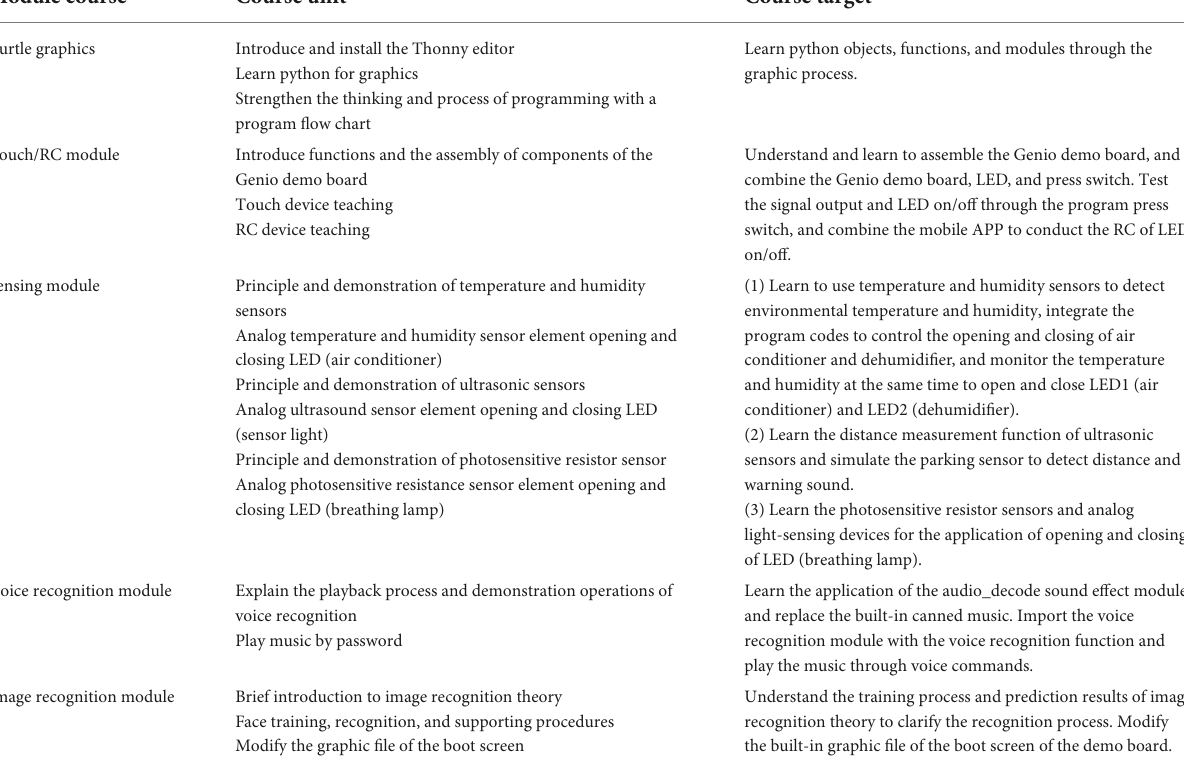
TABLE 5 Courses of five